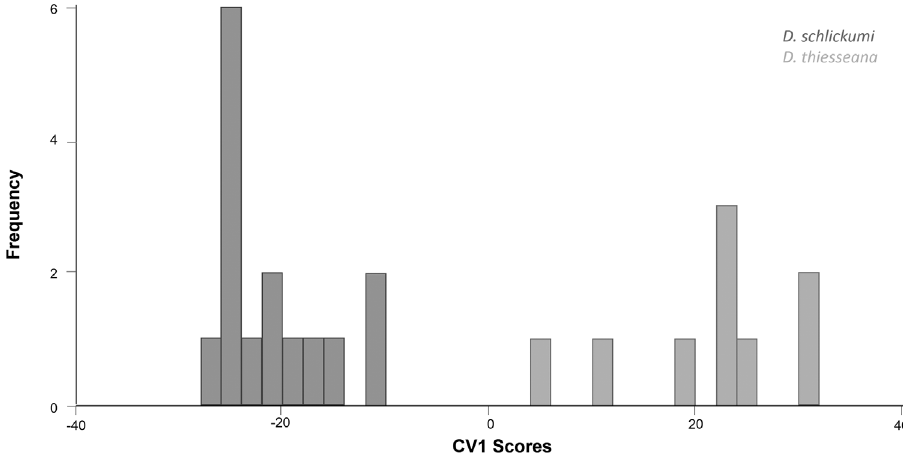
Figure 10. Canonical Variate Analysis: Dark-grey bins stand for Dianella schlickumi specimens and light- grey bins for Dianella thiesseana specimens.